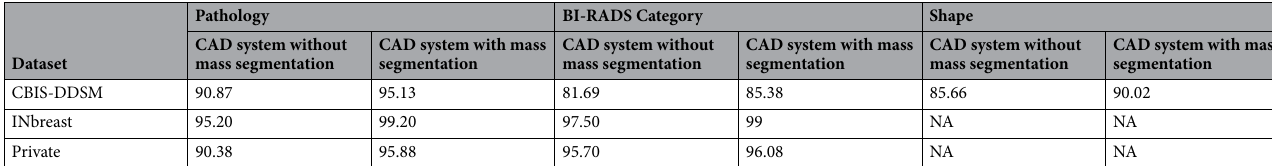
Table 13. Comparison of classification performance (accuracy %) using the proposed CAD system with and without mass segmentation.